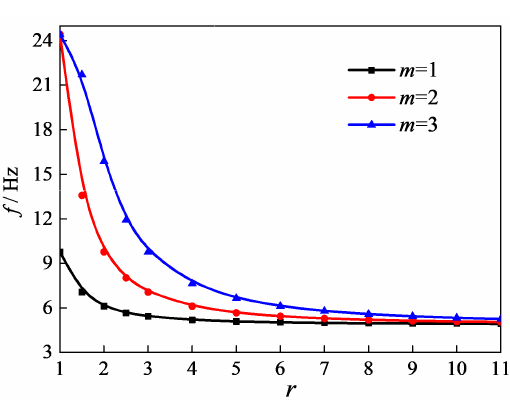
Figure 5: Realtionship between natural frequencies snd aspect ratio with S-S-S-S boundary condition